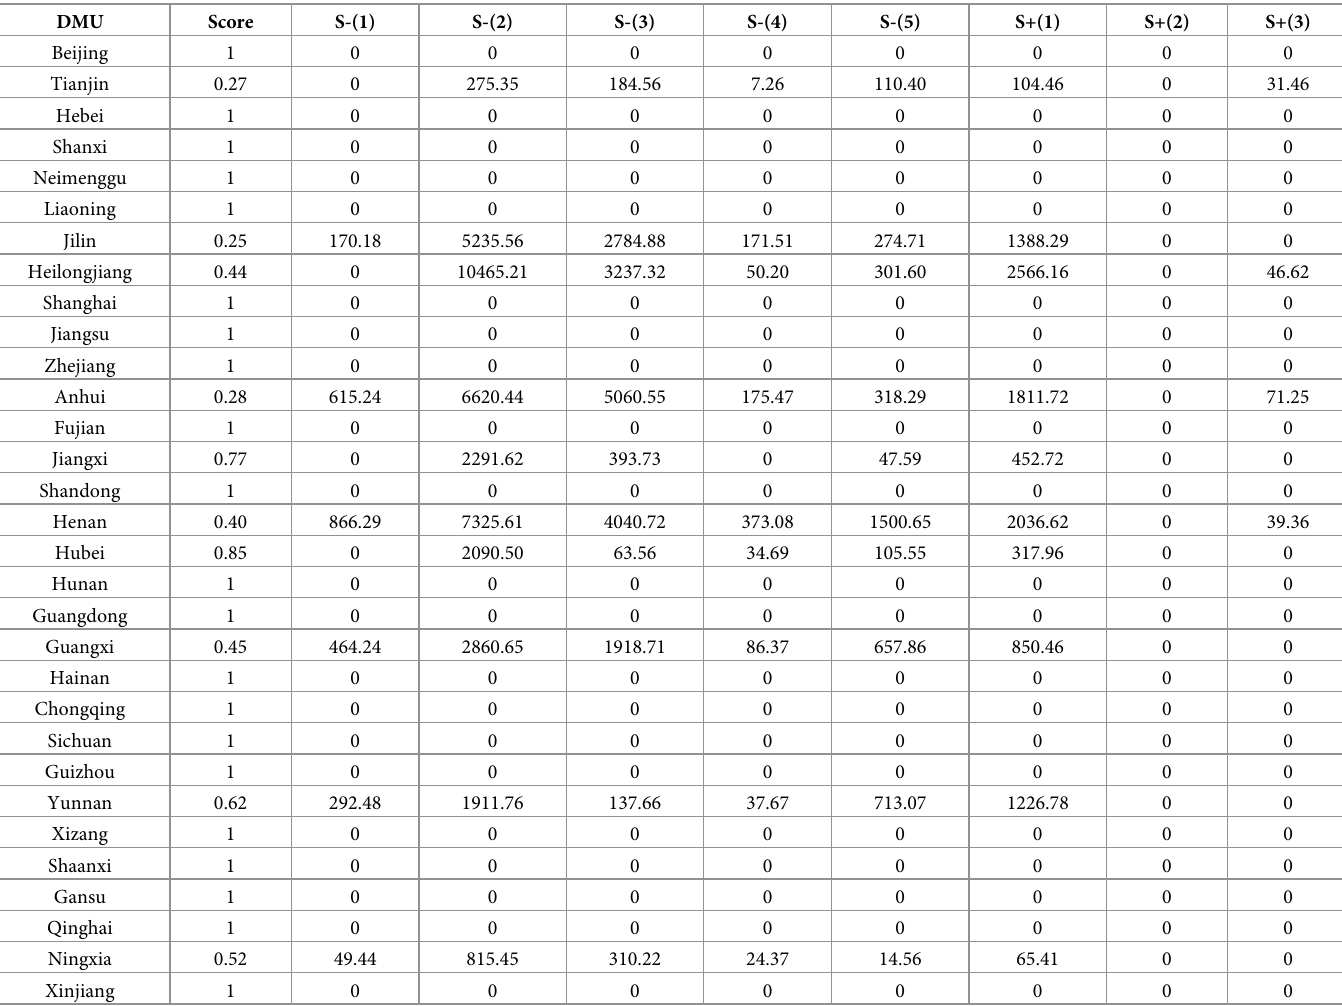
Table 2. Agricultural carbon emission efficiency evaluation of 31 provinces in